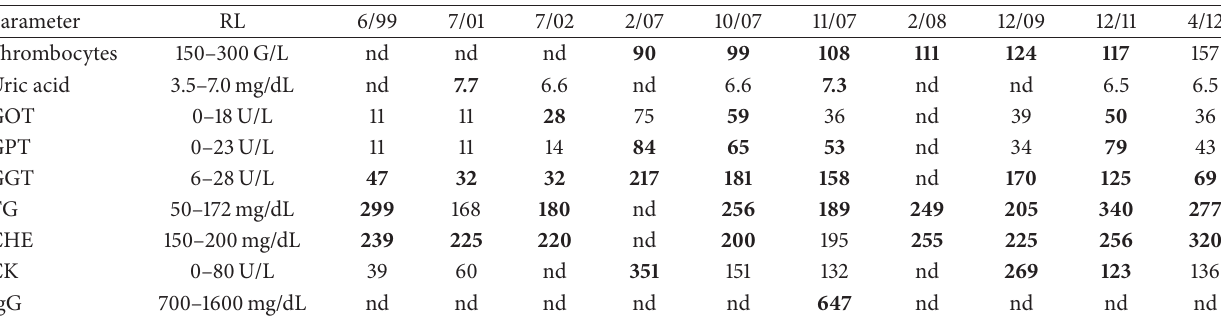
Table 1: Blood chemical values.